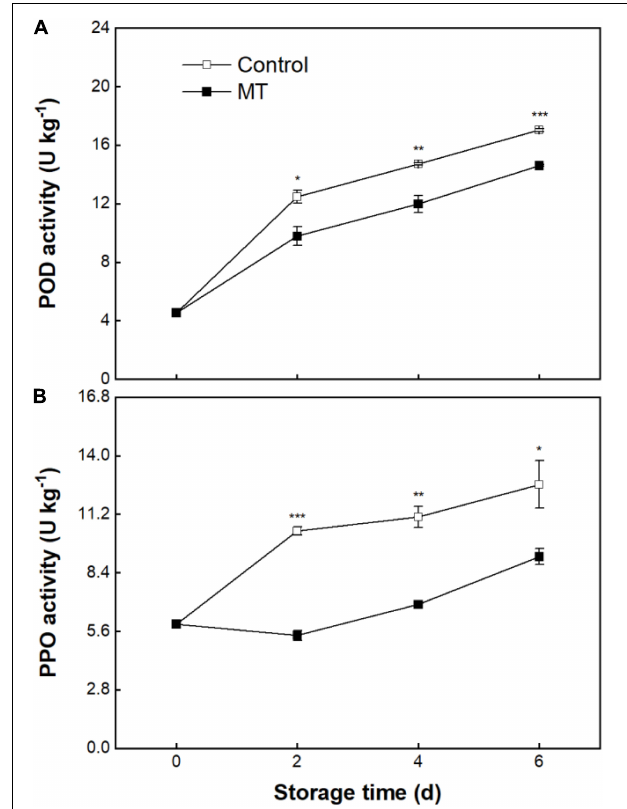
FIGURE 4 | Activities of peroxidase (POD) (A) and polyphenol oxidase (PPO) (B) in “Baoyan 7” rambutan fruit during storage at 25 ◦ C after treatment with 0.125 mmol L − 1 MT or water (control). The vertical lines represent the SE of triplicates while the asterisks indicate a significant difference between the MT group and the control group on the same day (* p < 0.05, ** p < 0.01, and *** p <